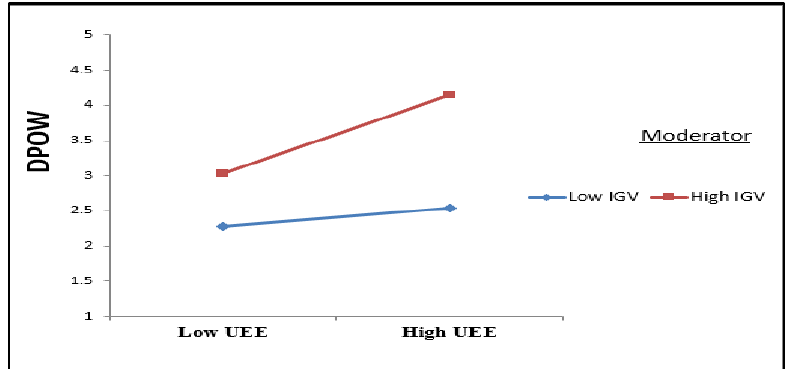
Figure 3. Interaction plot for the IGV moderation effect on UEE towards DPOW.